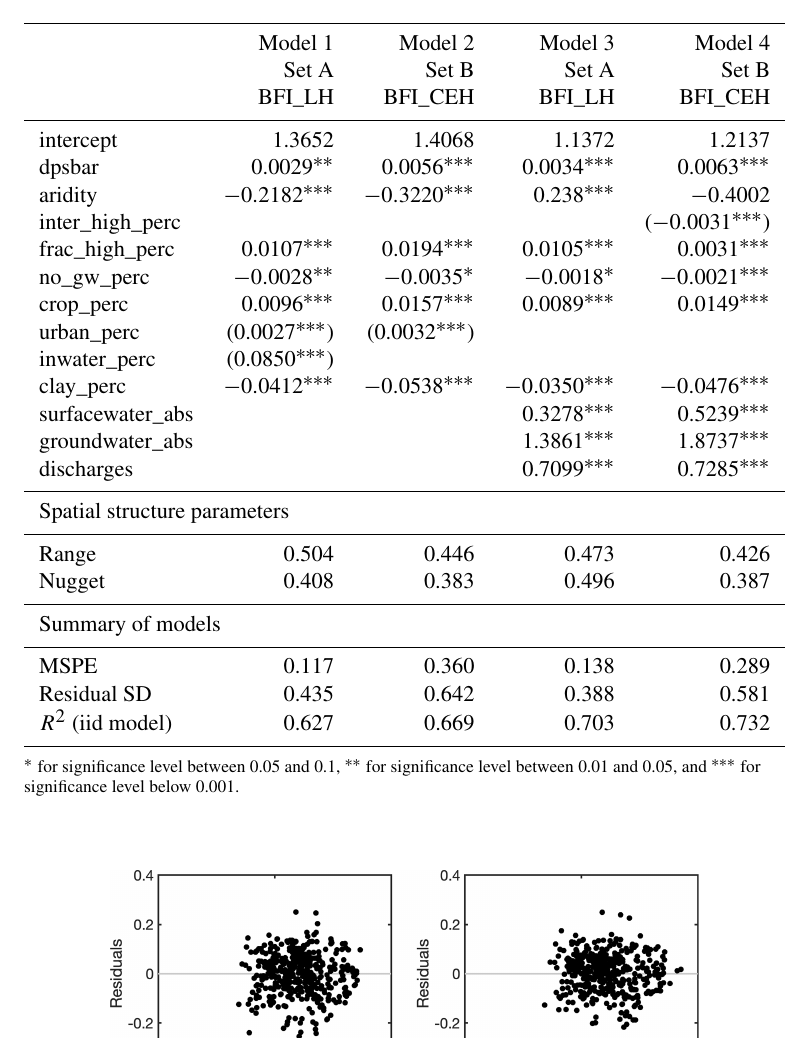
Table A2. Coefficients of the four LR models and associated spatial structural parameters and summary statistics for the models.